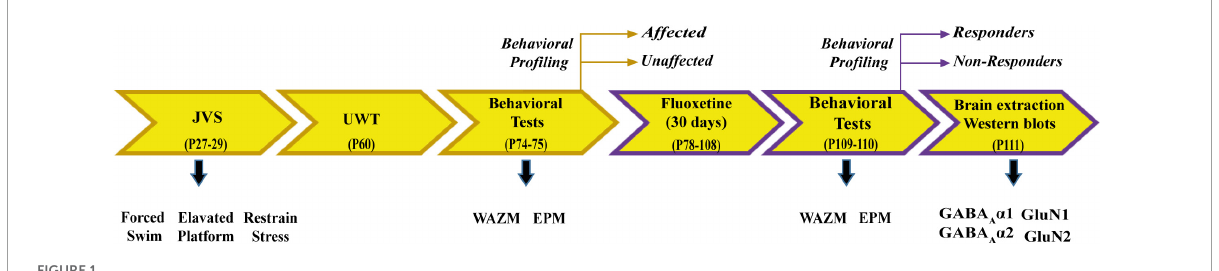
FIGURE1 Schematic representation of experimental paradigm